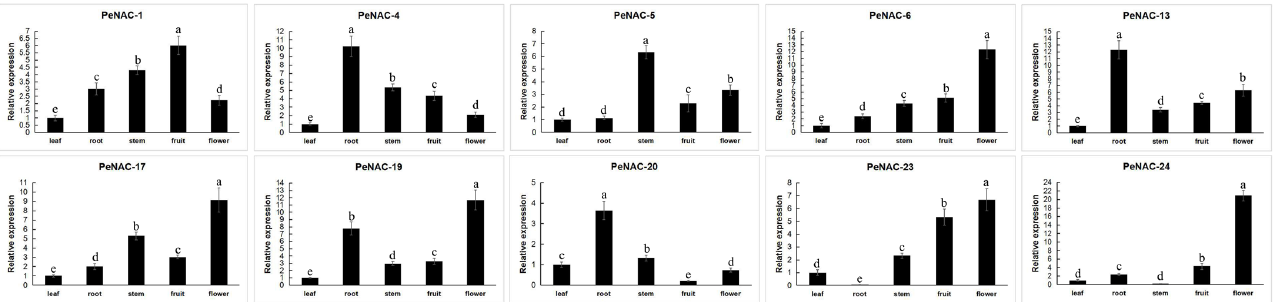
Figure 6. Expression analysis of 10 PeNACs in the leaf, root, stem, fruit and flower of the passion fruit. The leaf, root, stem, fruit, flower and fruits were obtained from the healthy passion fruit ( Passiflora edulis ). The details are shown in Table S5. Data are means ± SD of n = 3 biological replicates. Means denoted by the same letter are not significantly different at p < 0.05 as determined by Duncan’s multiple range test.